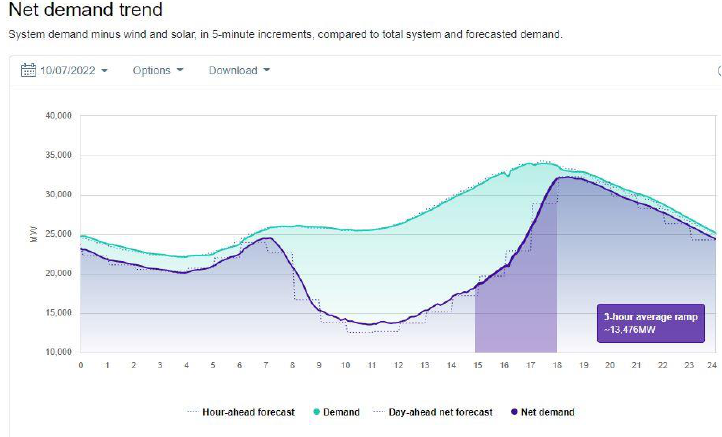
Figure 3. California ISO 10/07/22 Load Curve [8].